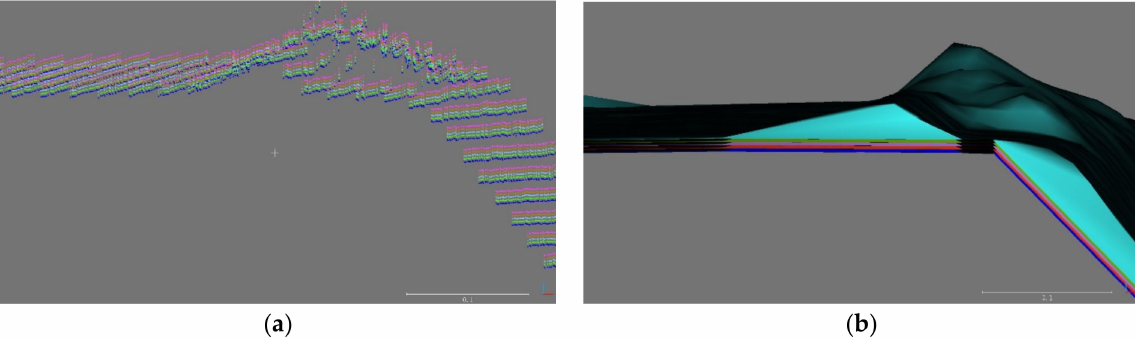
Figure 11. Example of artificial distance, ( a ) Shifted point clouds, ( b ) Shifted